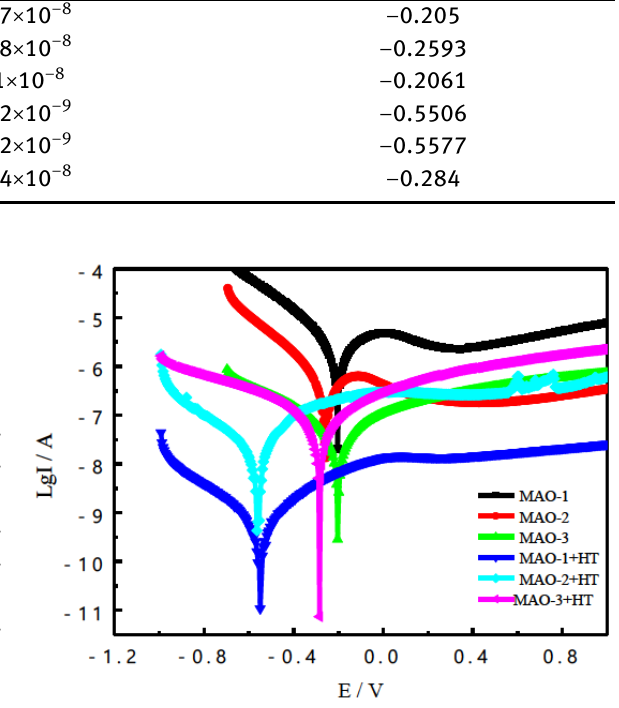
Table 3: Electrochemical parameters obtained from the polarization curves of Figure 4 Coatings